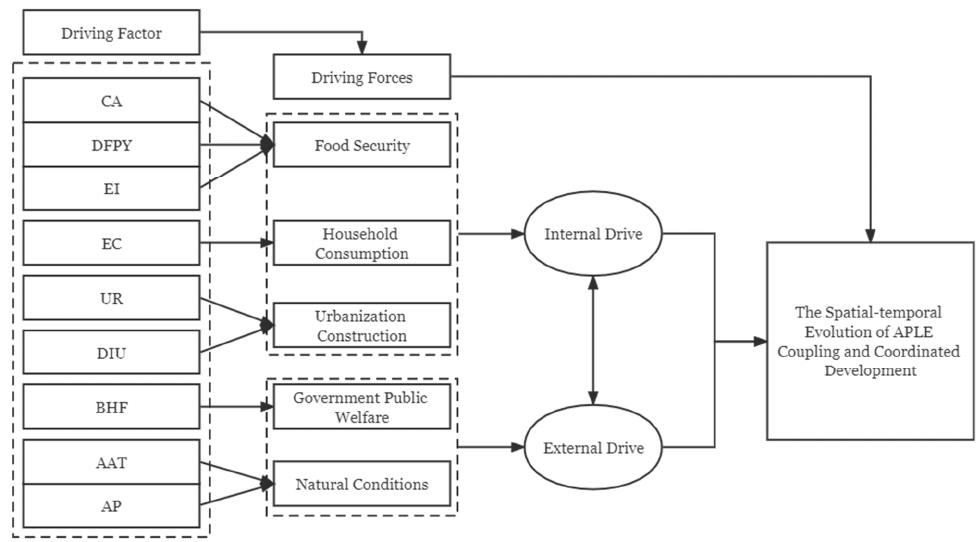
Figure 4. Driving mechanism of coupling and coordinated development of APLE system.